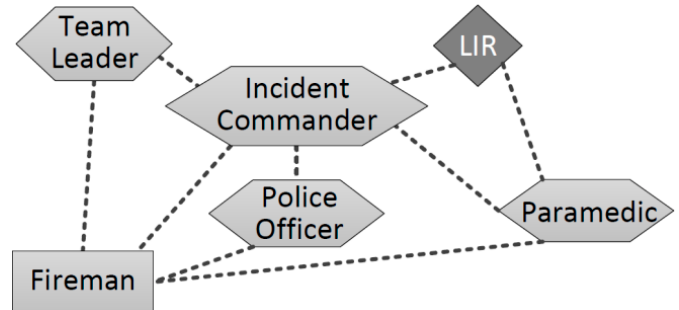
Figure 10. Interaction scenario